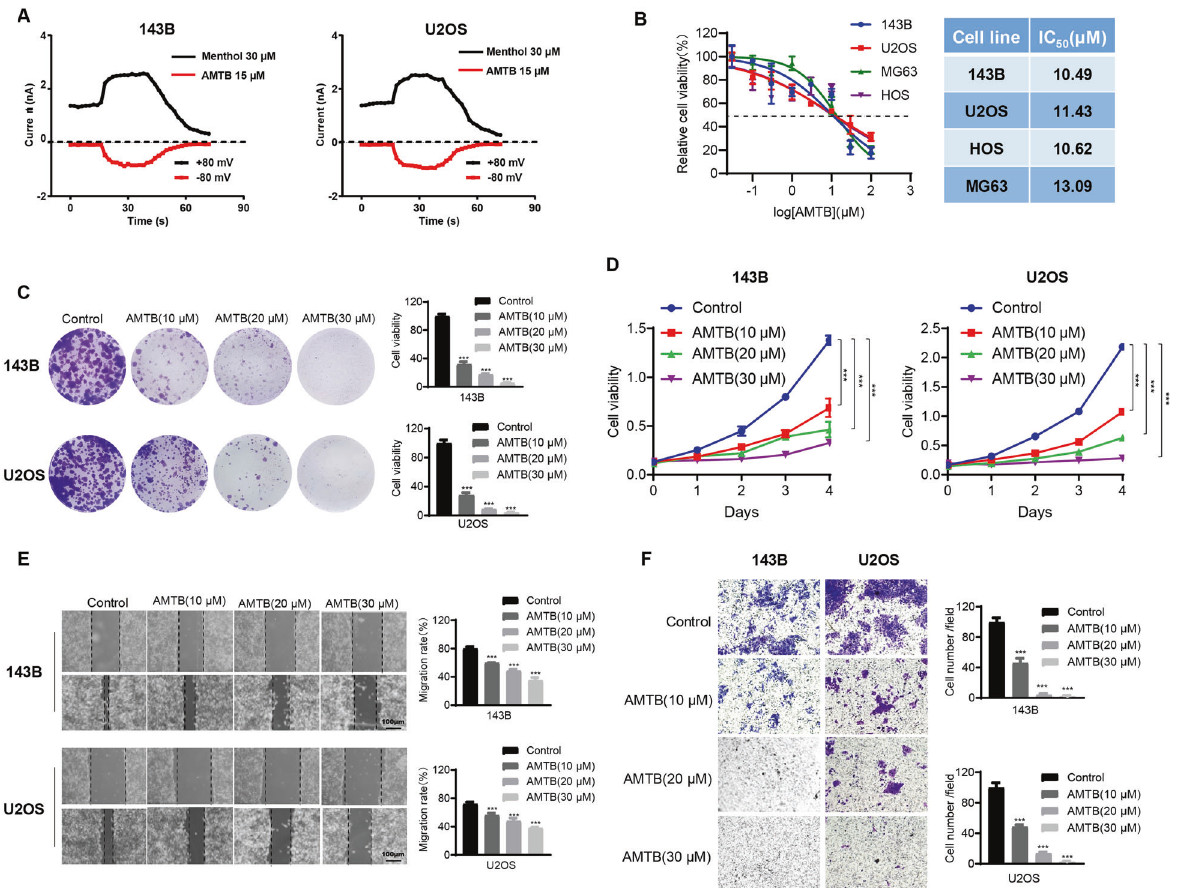
Fig. 2 AMTB suppresses osteosarcoma cell proliferation and migration in vitro. A Time course of menthol-induced whole-cell currents in 143B and U2OS cells pretreated with either 15 μ M AMTB or vehicle. B IC 50 values of four osteosarcoma cell lines after incubation with AMTB for 48 h. C Osteosarcoma cells treated with AMTB exhibited crippled ability of colony formation, and both the amount and the size of the colonies were reduced on a dose-dependent manner. The data was compared by one-way ANOVA with Tukey ’ s multiple comparison test and shown as mean ± s.d. *** P < 0.001. D AMTB suppresses osteosarcoma cell viability in a time- and dose-dependent manner. Osteosarcoma cells were treated with different concentrations of AMTB for indicated time, while cell viability was determined by the MTS assay. The data was compared by two-way ANOVA with Bonferroni test and shown as mean ± s.d. *** P < 0.001. E , F Osteosarcoma cells were treated with various concentrations of AMTB, and their migration ability was assessed by the wound healing assay and the transwell assay. The data was compared by one-way ANOVA with Tukey ’ s multiple comparison test and shown as mean ± s.d. *** P <